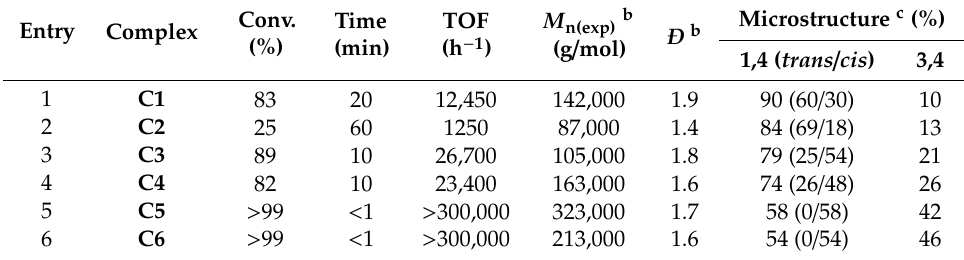
Table 2. Polymerization of 5000 equiv. of isoprene / Fe using C1 – C6 / Al i Bu 3 / [Ph 3 C][B(C 6 F 5 ) 4 ] catalytic systems